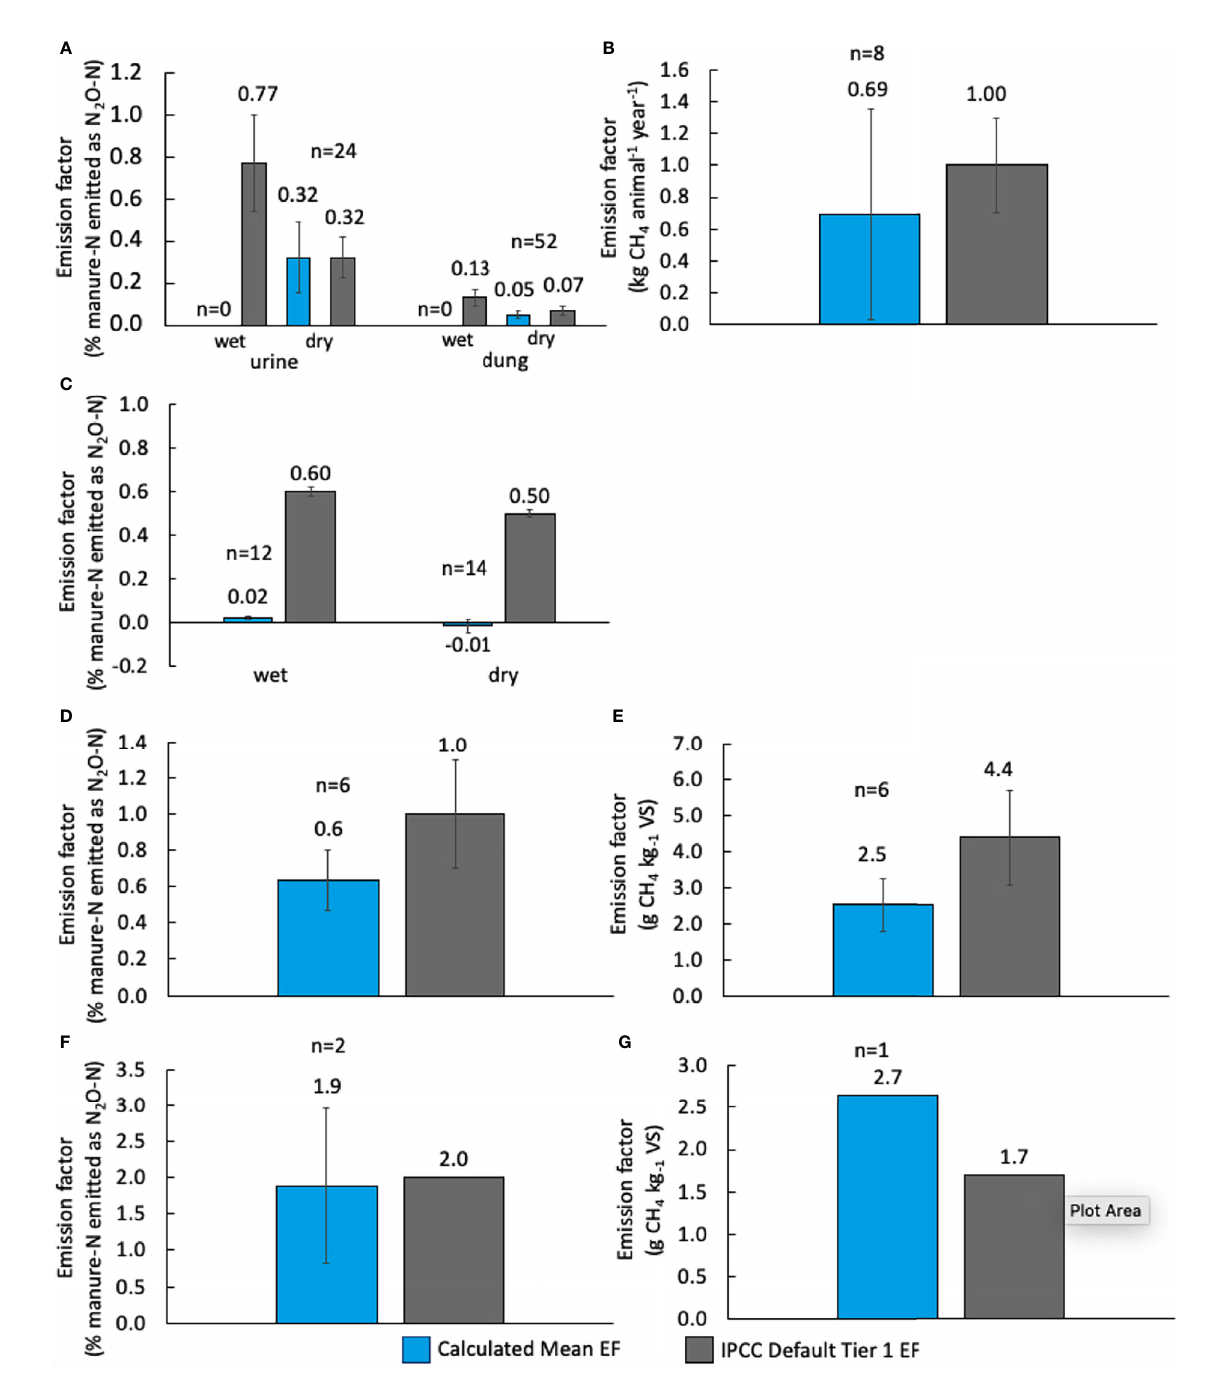
FIGURE 4 | Calculated means of EFs for different categories of manure in sub-Saharan Africa. Bars show mean 95% CI of reported observations and IPCC 2019 defaults ± uncertainty (expressed as percentage) for N 2 O (A) and CH 4 EFs (B) for manure on pasture, range, and paddock (deposited manure) disaggregated by climate ( ‘ wet ’ , ‘ dry ’ ) and excreta type ( ‘ dung ’ , ‘ urine ’ ); (C) N 2 O EF for manure applied as organic fertilizer (applied manure); EFs for N 2 O (D) and CH 4 (E) for manure managed as “ solid storage ” ; EFs for N 2 O (F) and CH 4 (G) for manure managed as “ drylot ” (i.e. livestock enclosures). The EF for N 2 O are reported as the proportion of N in manure that is emitted as N 2 O. The EFs for CH 4 from deposited manure (A) are reported in kg of CH 4 emitted per animal per year, whereas manure management EFs (D – G) are reported in g CH 4 emitted per kg of manure volatile solid (VS). n = number of observations for each manure category and GHG used for mean ± 95% CI